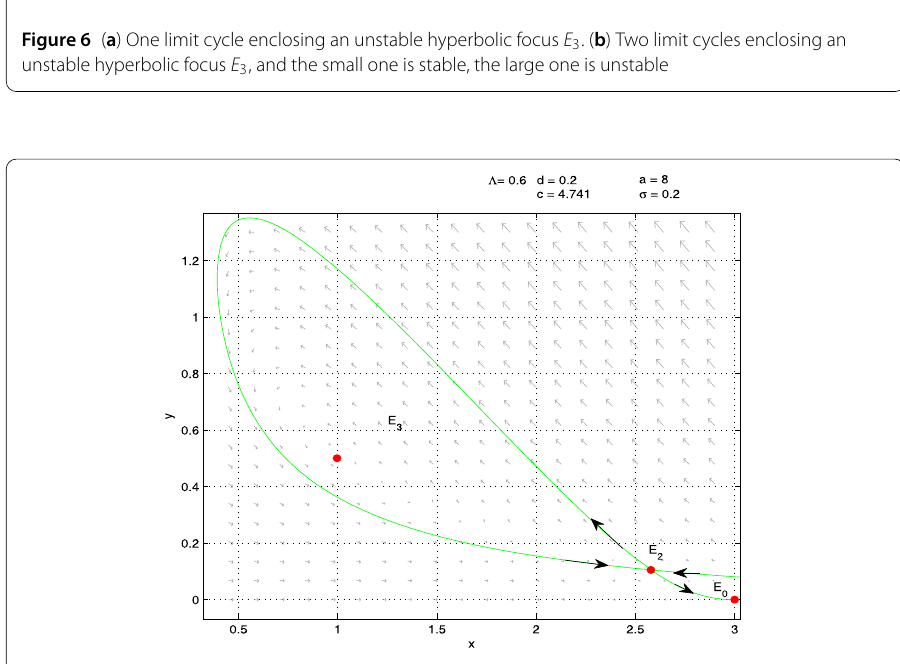
Figure 7 Equilibrium E 3 is stable and there exists an unstable homoclinic